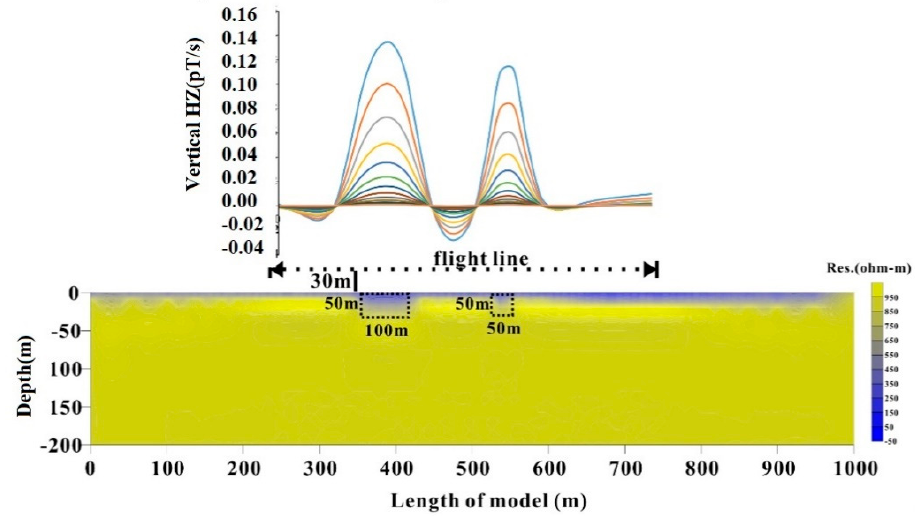
Figure 4. Geo-electrical simulation model and numerical calculation results.